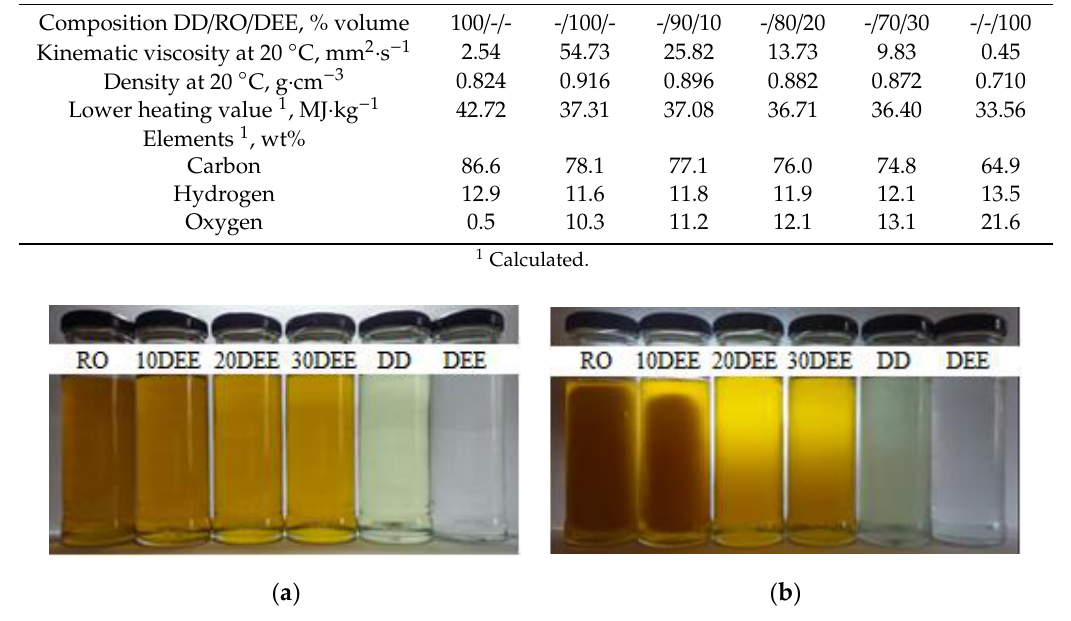
Figure 2. Fuel samples at different temperatures: +20 °C ( a ) and −25 °C ( b ).